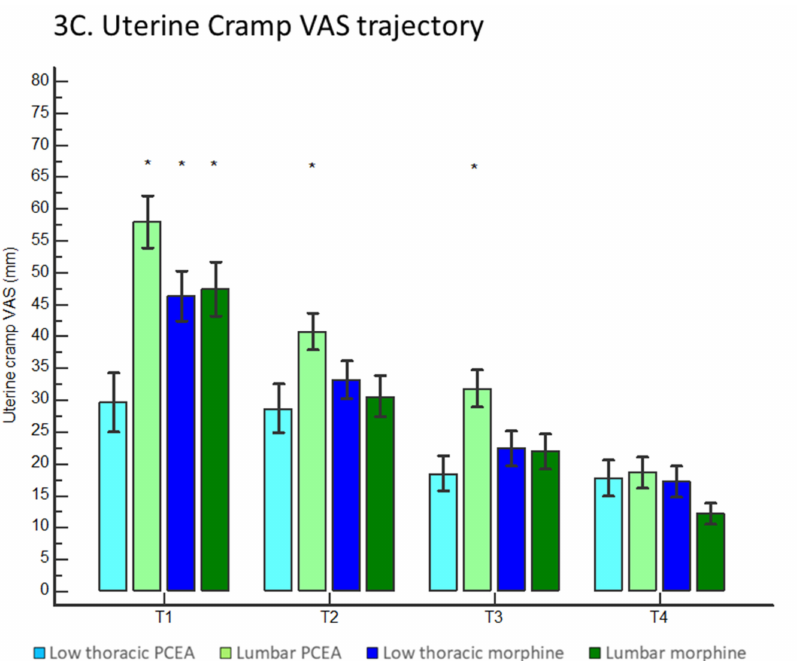
Figure 3. ( A ). Time trajectory changes in the visual analog scale of static wound pain. * means a p value < 0.05 compared to that of the low thoracic PCEA group. The low thoracic PCEA achieved a particularly superior static VAS score than those of the lumbar PCEA through T 1 to T 3 . ( B ) Time trajectory changes in the visual analog scale of dynamic wound pain. * means a p value < 0.05 compared to that of the low thoracic PCEA group. The low thoracic PCEA achieved the lowest dynamic VAS score at T 1 compared to the other three study groups. The beneficial analgesic effects of low thoracic PCEA were also observed at T 2 and T 3 when compared to those of the lumbar PCEA. ( C ). Time trajectory changes in the visual analog scale of uterine cramp. * means a p value < 0.05 compared to that of the low thoracic PCEA group. The low thoracic PCEA achieved the lowest uterine cramp VAS score at T 1 compared to the other three study groups. The beneficial analgesic effects of low thoracic PCEA were also observed at T 2 and T 3 in comparison to those of the lumbar